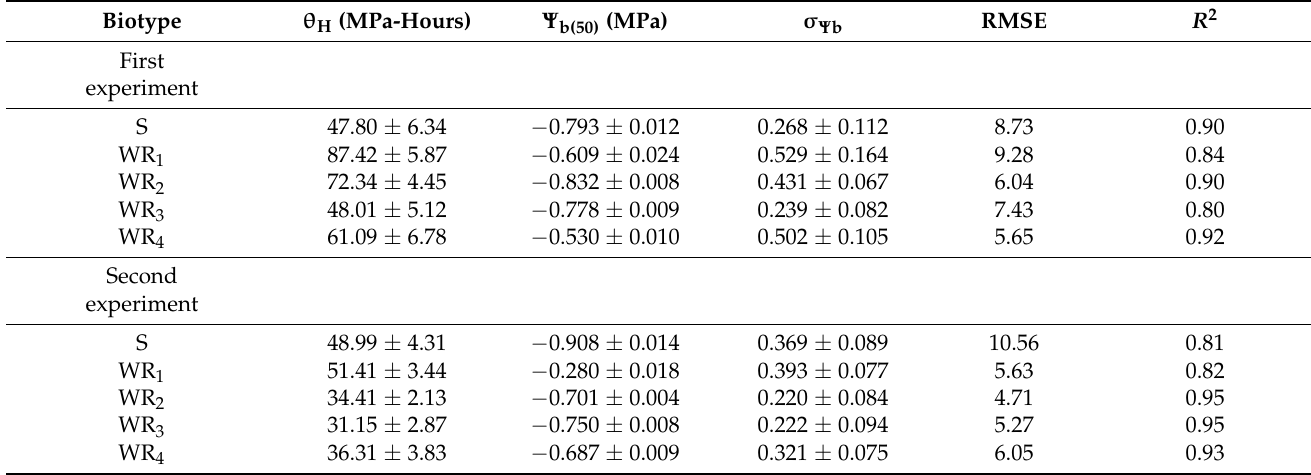
Table 6. Hydrotime constant ( θ H ), median base water potential ( Ψ b(50) ), standard deviation of the ψ b(g) ( σ Ψ b ). Coefficient of determination ( R 2 ) and Root Mean Square Error (RMSE)for susceptible (S) and resistant biotypes (WR 1 –WR 4